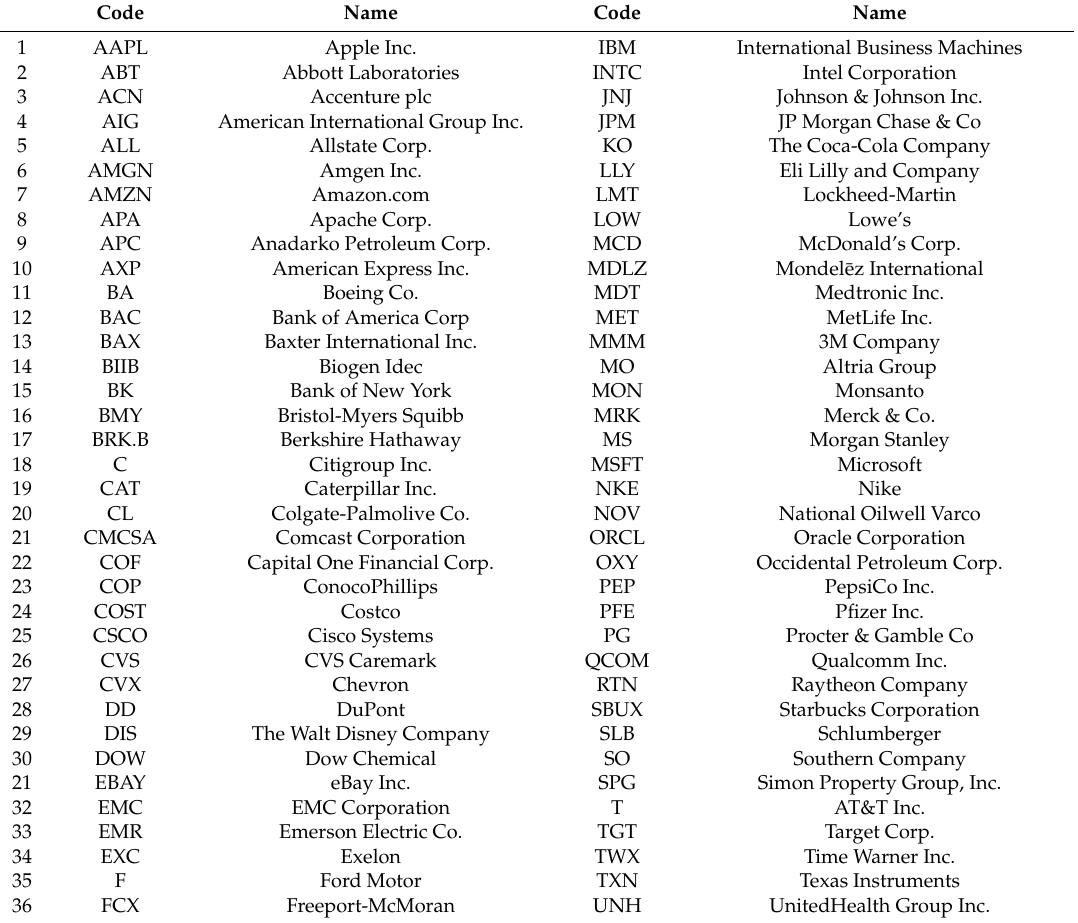
Table B2. S&P 100 company codes and